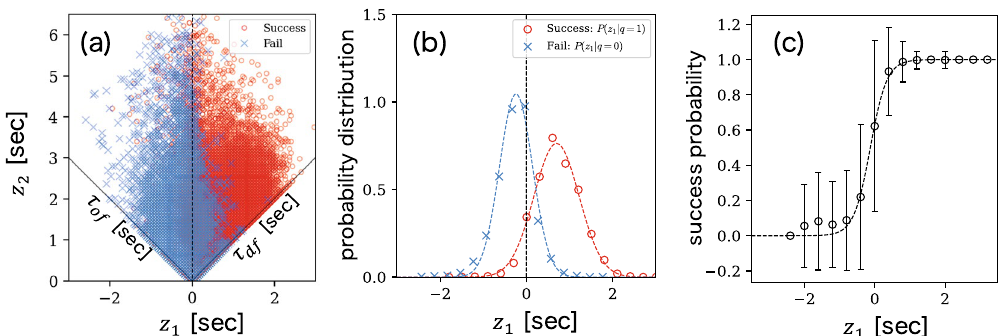
x t z x t Figure 3. ( a ) Scatter plot of z 1 ( e , o ) and 2 ( e , o ) for 34,189 passes obtained from 45 football games. Plots (cid:31) (cid:31) for failed and successful passes almost distribute in z 1 < 0 and z 1 > 0 domains, respectively. ( b ) Probability x t distributions of z 1 ( e , o ) for successful and failed passes. The dotted curves are the fitted normal distribution (cid:31) x t curves. ( c ) Success probability of passes as a function of z 1 ( e , o ) . The success probabilities are calculated by (cid:31) averaging the value of q over each z 1 . The dotted curve is the fitted sigmoid function given by Eq. (5), indicating x at time t x , t ) signifies the degree of safety for a pass made to that z 1 ( (cid:31) (cid:31)